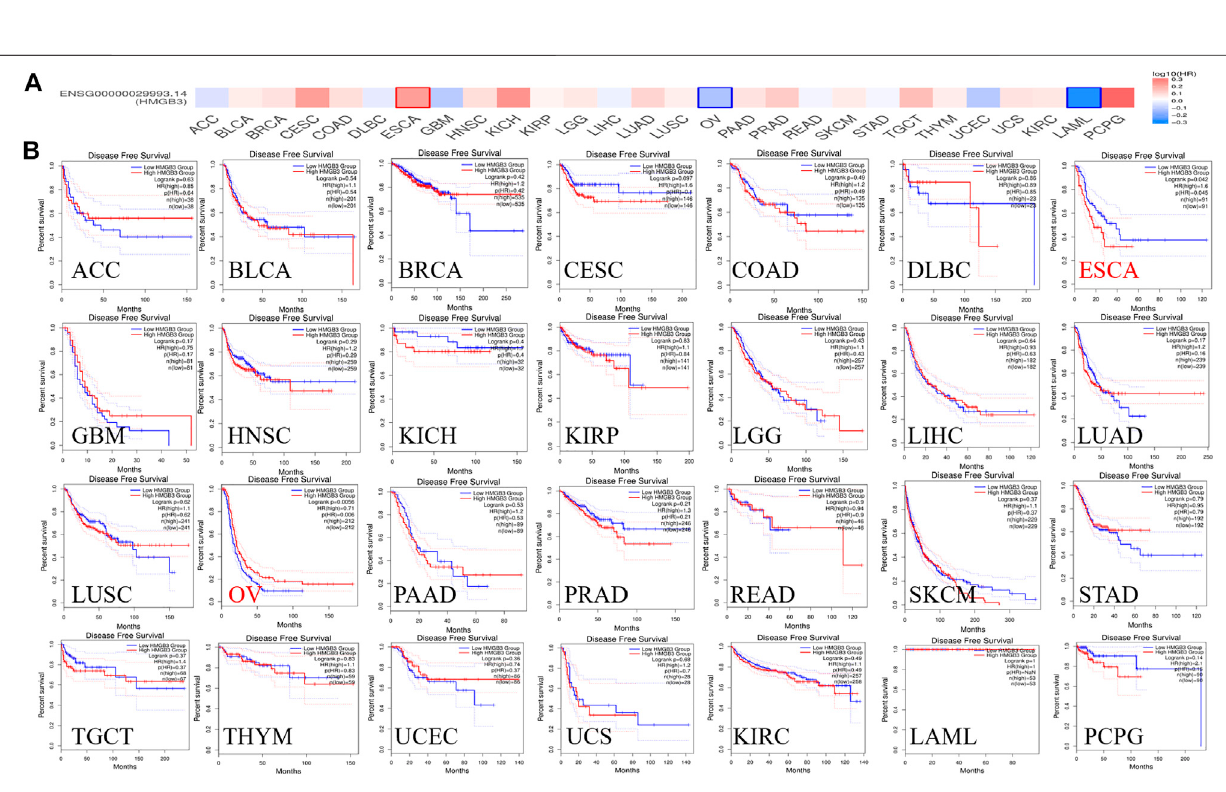
Frontiers in Cell and Developmental Biology |